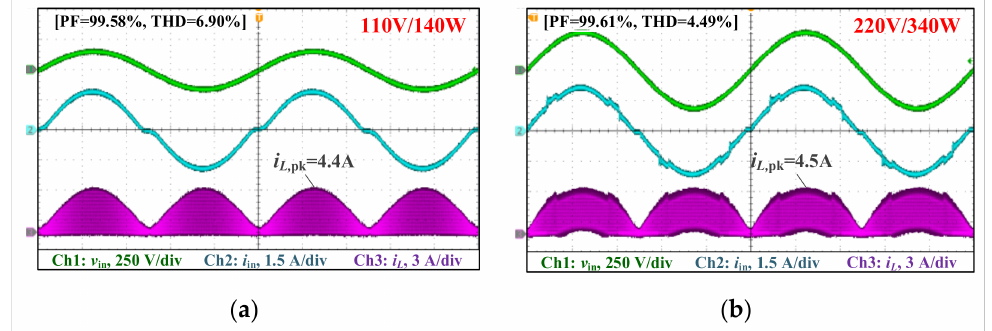
Figure 14. Waveforms at half power. ( a ) 110 V/140 W; ( b ) 220 V/340 W.